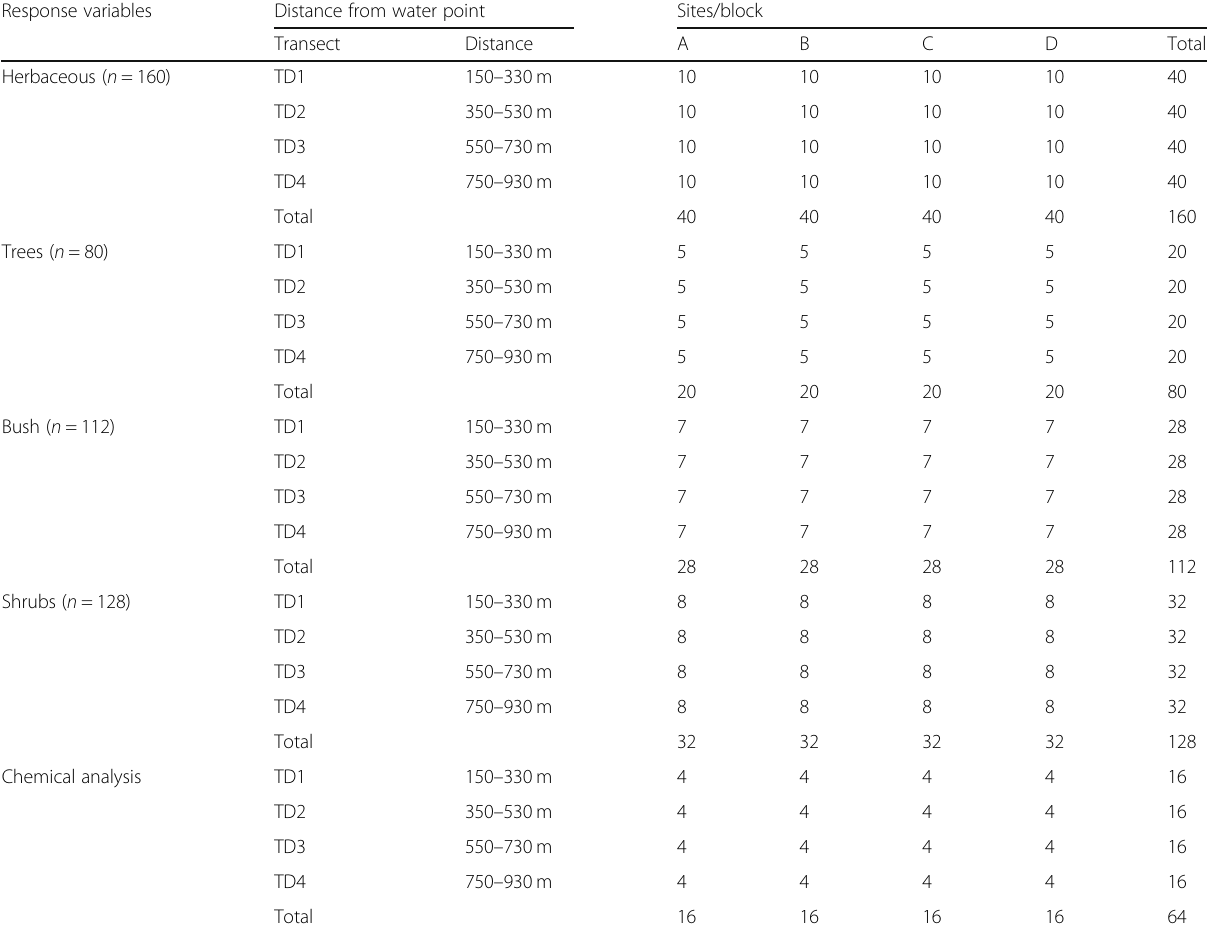
Table 1 Experimental design of the study and plant biomass samples per block (site) in Chagni ranch, Northwest Ethiopia Response